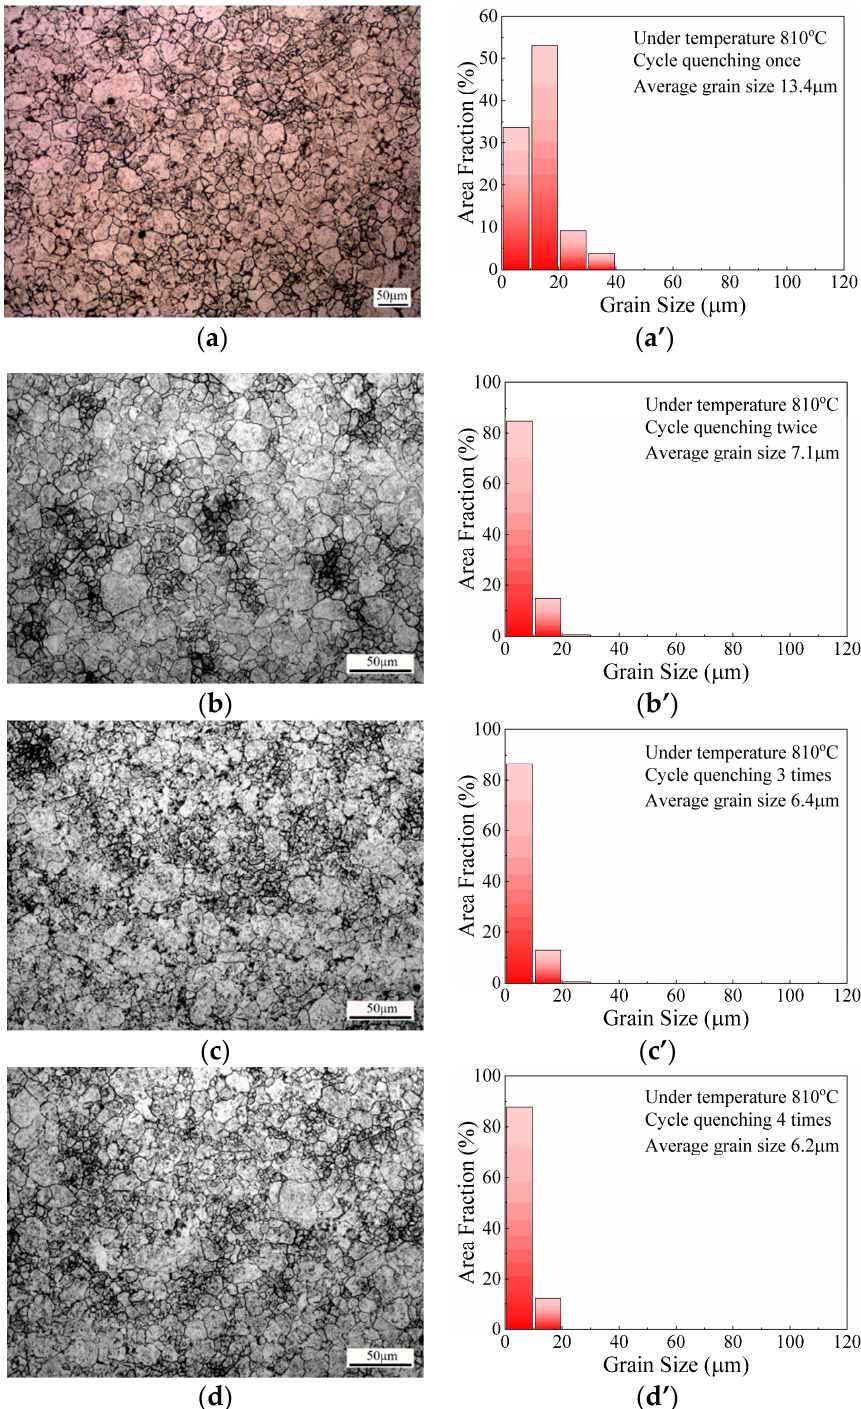
Figure 10. Microstructures and grain size distributions of specimens subjected to different cyclic quenching times at the optimal cyclic quenching temperature of 810 °C: ( a )-( a’ ) once; ( b )-( b’ ) twice; ( c )-( c’ ) 3 times; ( d )-( d’ ) 4 times .